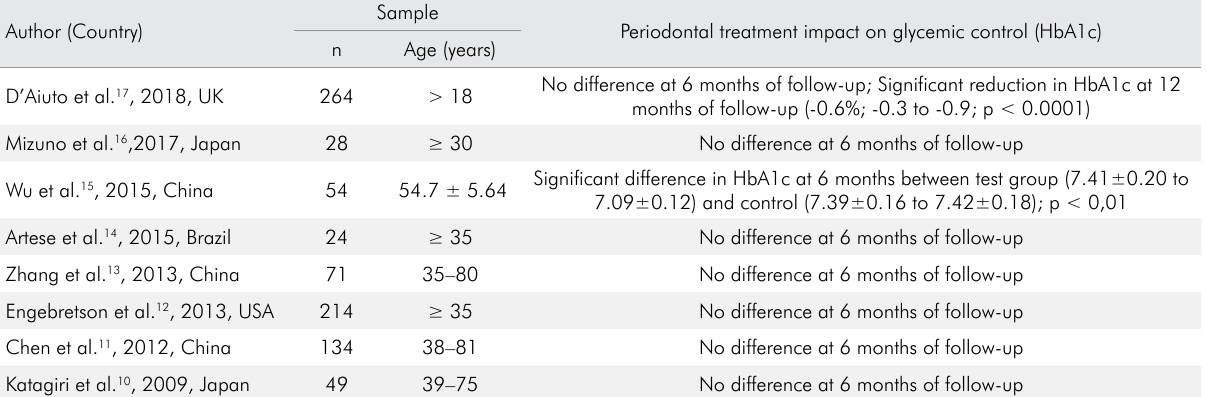
Table. Randomized clinical trials with at least 6 months of follow-up that evaluated the effect of periodontal treatment in type 2 diabetic patients. Comparison between groups that underwent periodontal treatment (test) or not